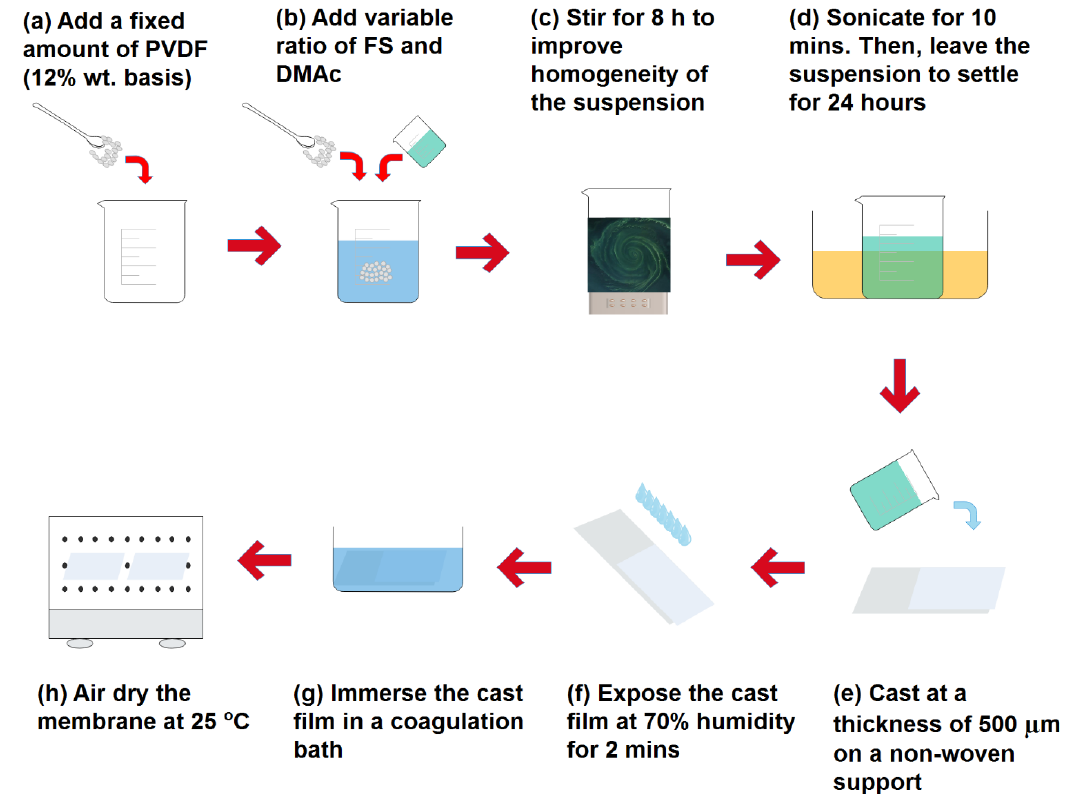
Figure 1. Fabrication of PVDF / FS membranes; ( a ) a fixed amount of PVDF was first added into a beaker, ( b ) variable ratios of FS and DMAc were added, ( c ) stirred for 8 h, ( d ) sonicated for 10 min in a sonication bath to remove all bubbles, ( e ) membranes were cast on a non-woven support layer, ( f ) the cast layer was exposed for 2 min at 70% humidity after which it was immersed in a coagulation bath, and ( g ) the membrane was air-dried for 24 h at 25 °C.